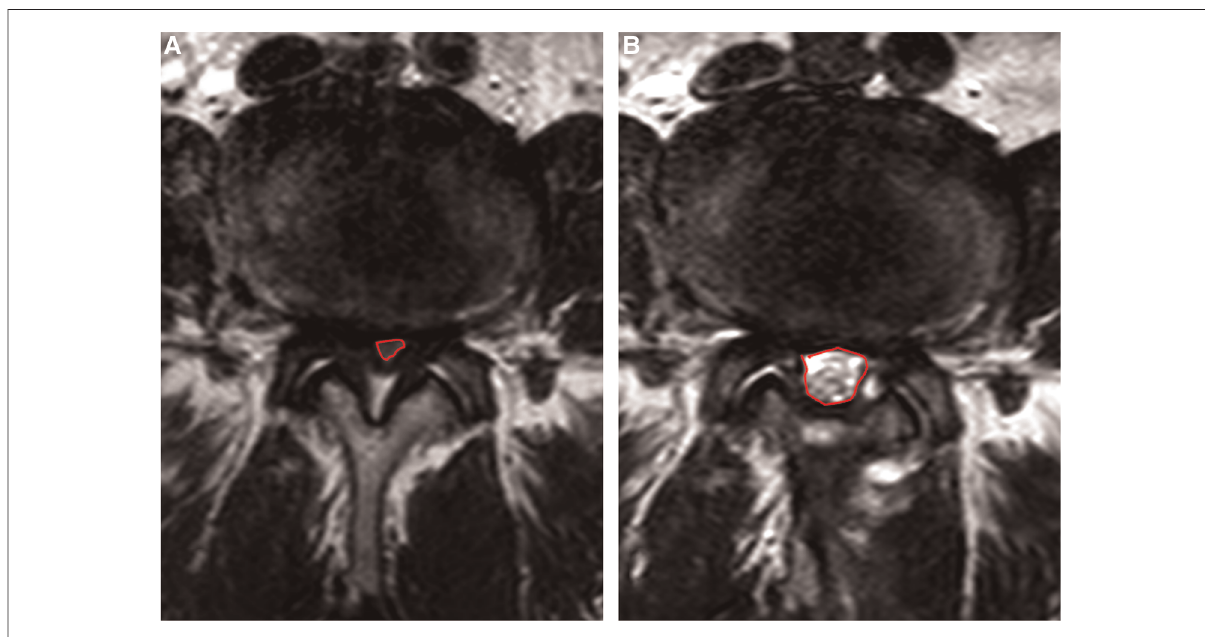
FIGURE 4 Dural sac cross-sectional area calculation under MRI. ( A ) Preoperative calculation; ( B ) Postoperative calculation.